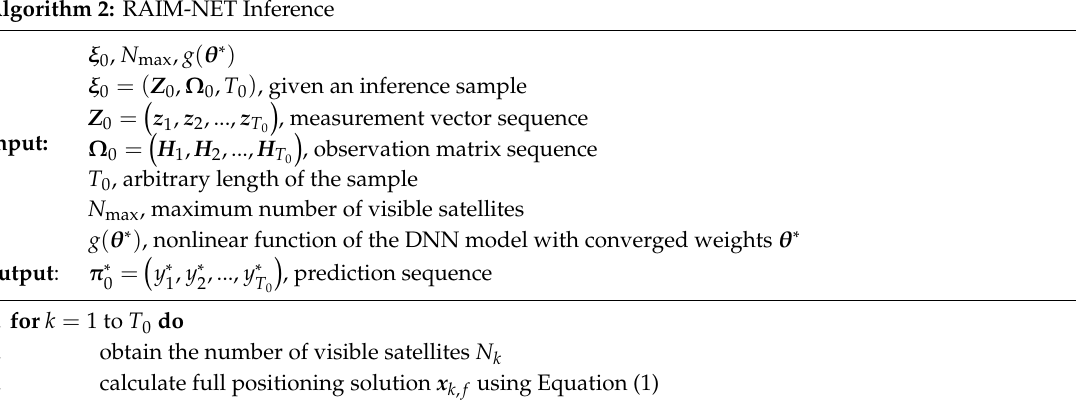
Algorithm 2: RAIM-NET